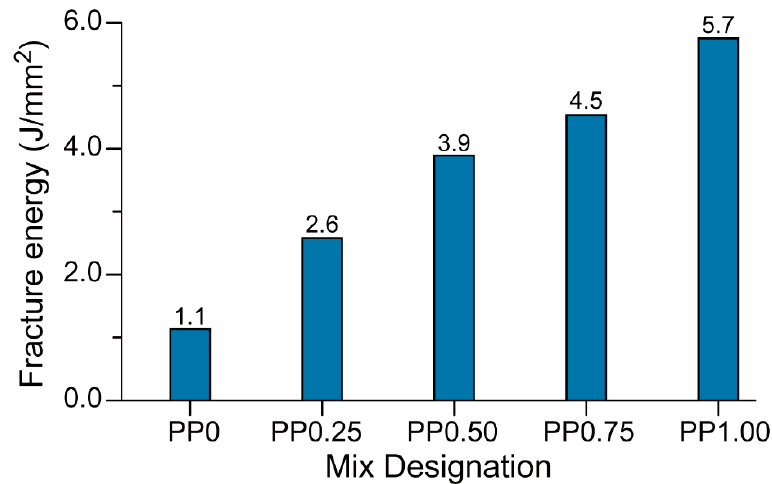
Figure 11. The fracture energy values of 3D-printed specimens obtained from the three-point bend tests.